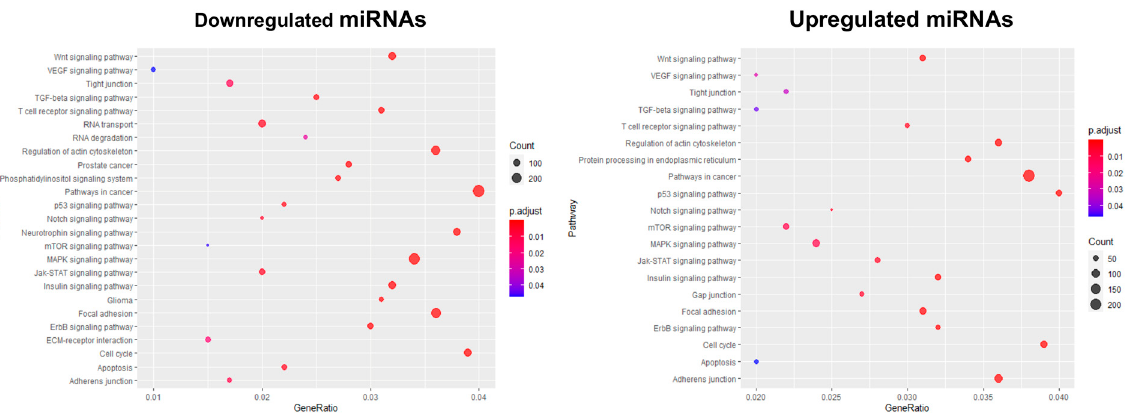
Figure 5. Signaling pathway analysis by KEGG for downregulated miRNA target genes in 3D organotypic cultures. Bubble plot of the KEGG enrichment analysis is shown, on the y -axis the enriched pathways of miRNAs downregulated in 3D organotypic cultures ( left panel ) and miRNAs overexpressed in 3D cultures ( right panel ) are shown. The size of the circle represents the number of genes involved in that pathway. The color represents the p -adjusted value.